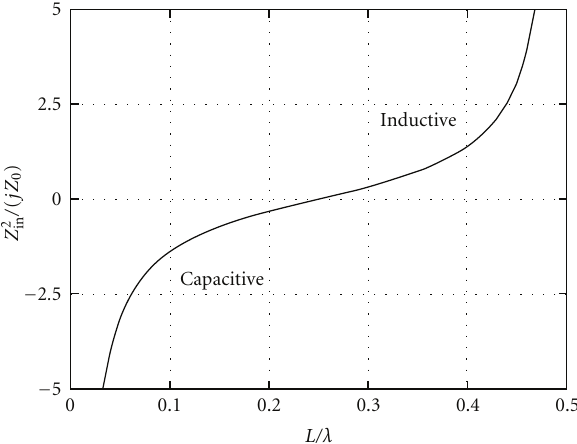
Figure 4: The input impedance of the CPW open stub feed